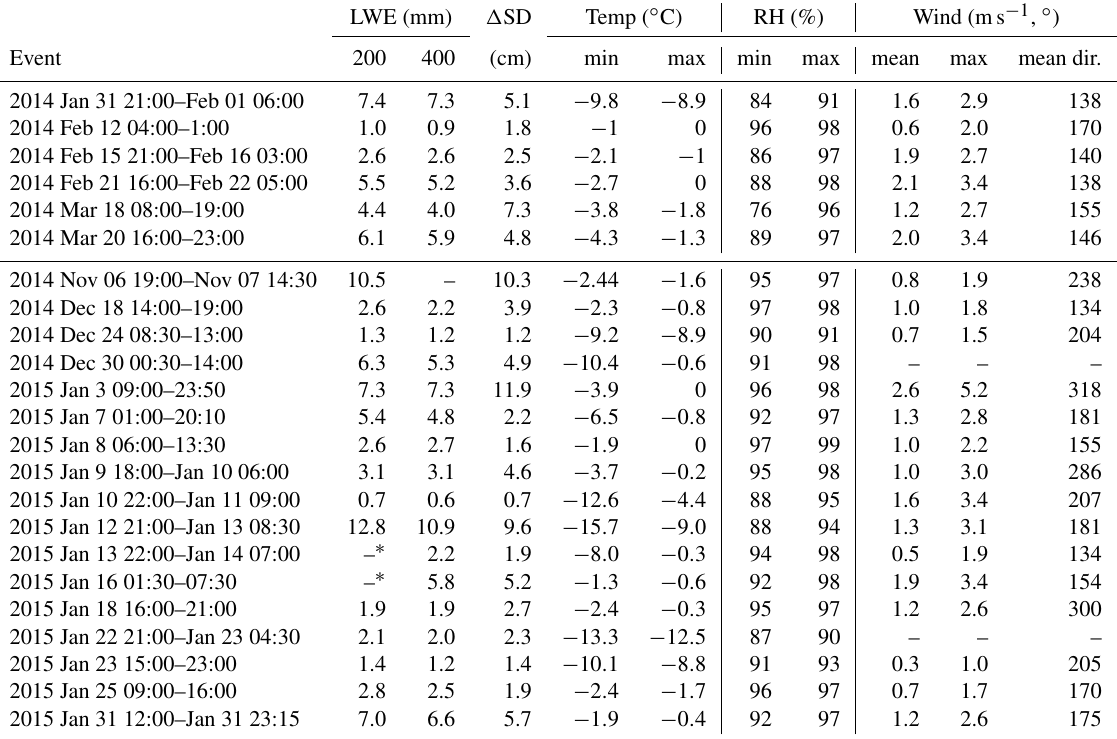
Table 1. Liquid water equivalent precipitation accumulation measured with Pluvio 2 200 and 400, change in snow depth and maximum and minimum temperature, maximum and minimum relative humidity, mean and maximum wind speed and mean wind direction of the studied snow events. Events before the horizontal line are recorded during the BAECC